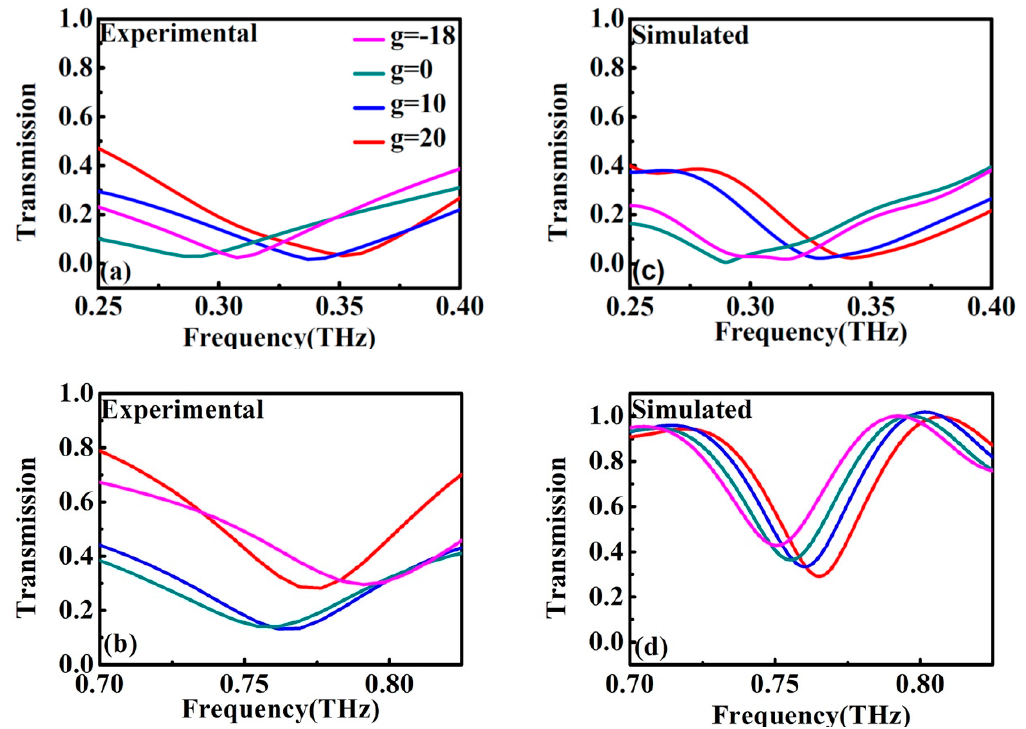
Figure 2. Experimental ( a , b ) and simulated ( c , d ) amplitude transmission spectra for samples with different values of g, when the E field is parallel to the x -axis.